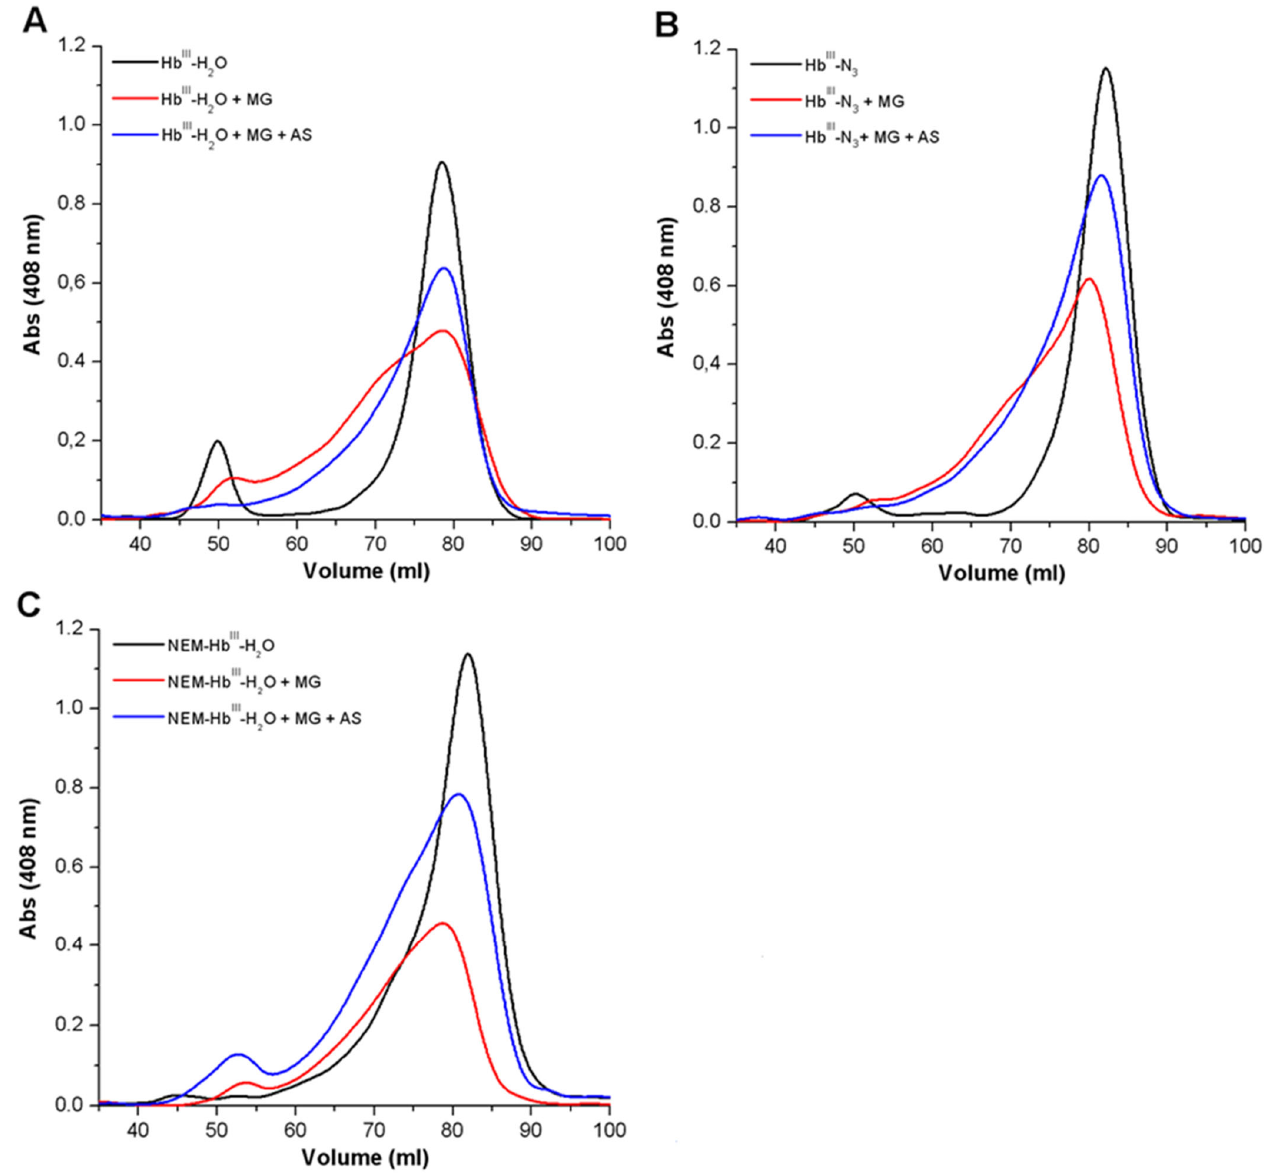
Figure 3. Hb elution profiles from the Toyopearl HW ‐ 55F column. ( A ) metHb ‐ H 2 O; ( B ) metHb ‐ N 3 ; ( C ) NEM ‐ metHb ‐ H 2 O. The control (without MG), black curves; with MG (13.5 mM), red curves; with MG (13.5 mM) + Angeli’s salt (8 mM), blue curves. Reaction mixtures, as in Figure 2.